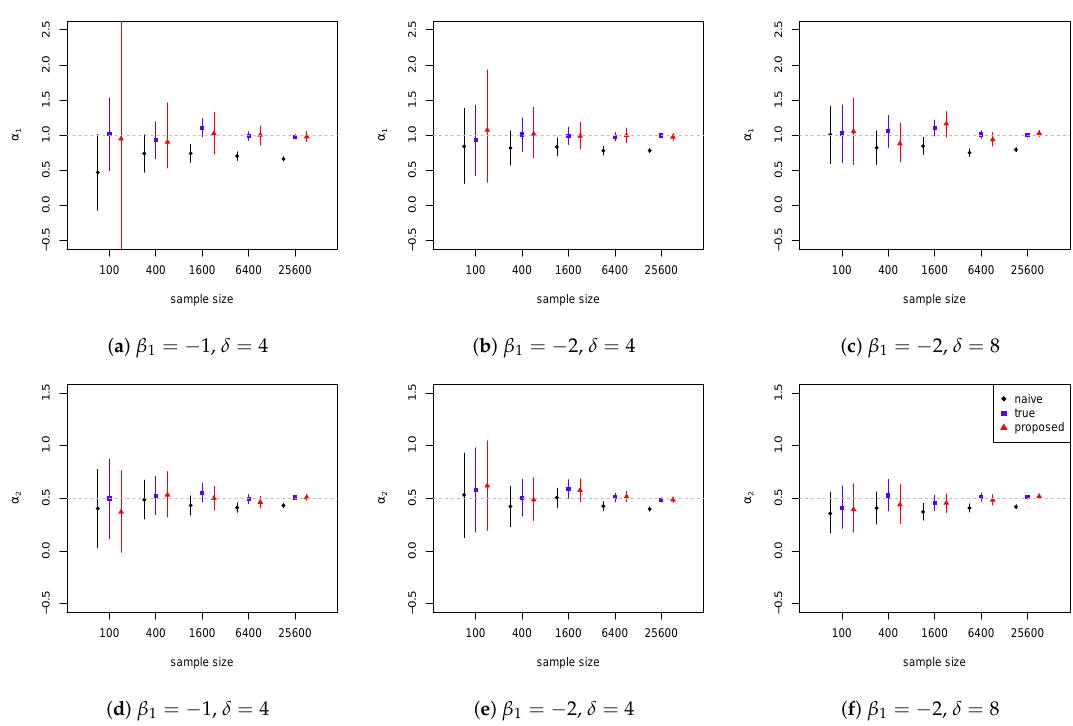
Figure 5. Credible intervals for the risk effects of V (top) and X (bottom) for the Pareto loss severity model. The dashed line marks the true value.